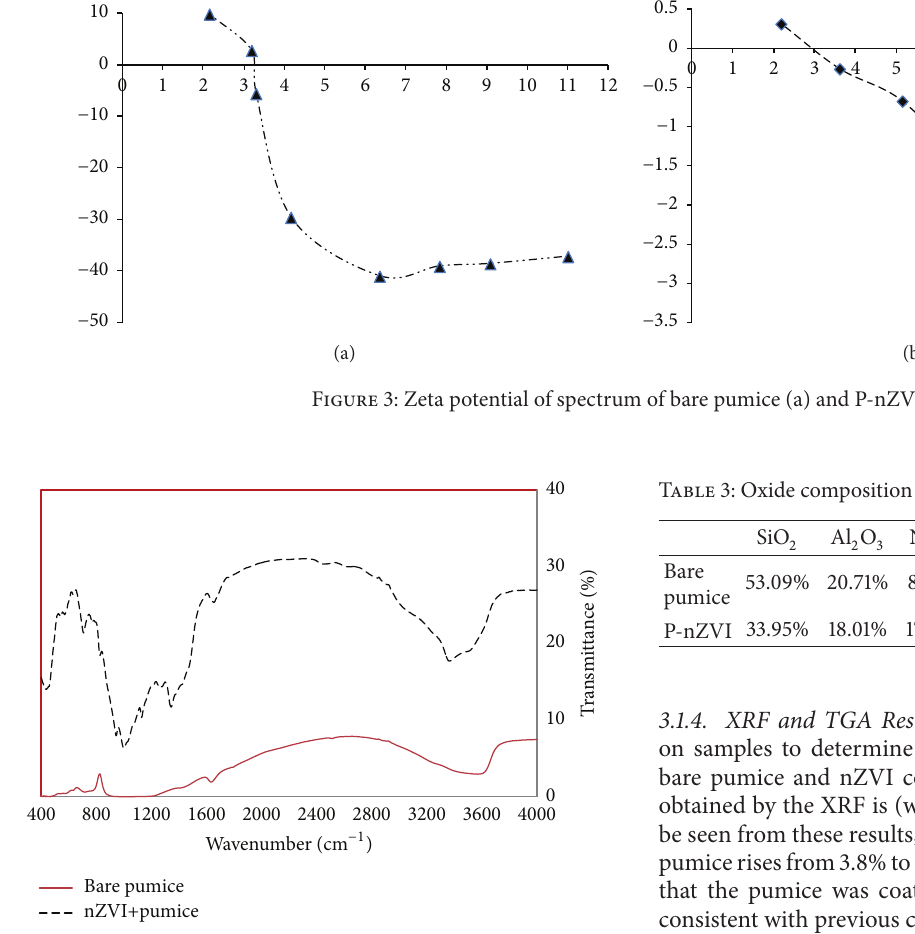
Figure 4: FTIR spectra of bare pumice and P-nZVI samples.